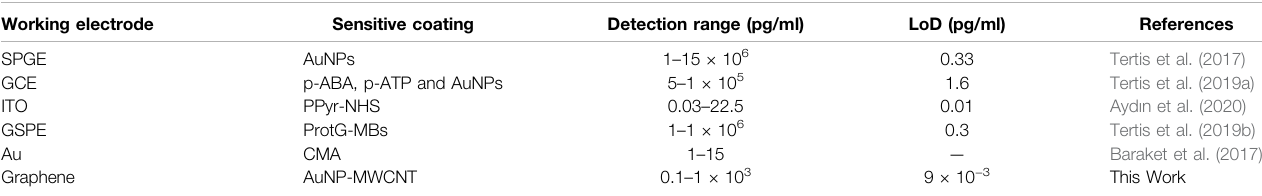
TABLE 3 | Comparative analysis of the developed sensor and the previous works. Working